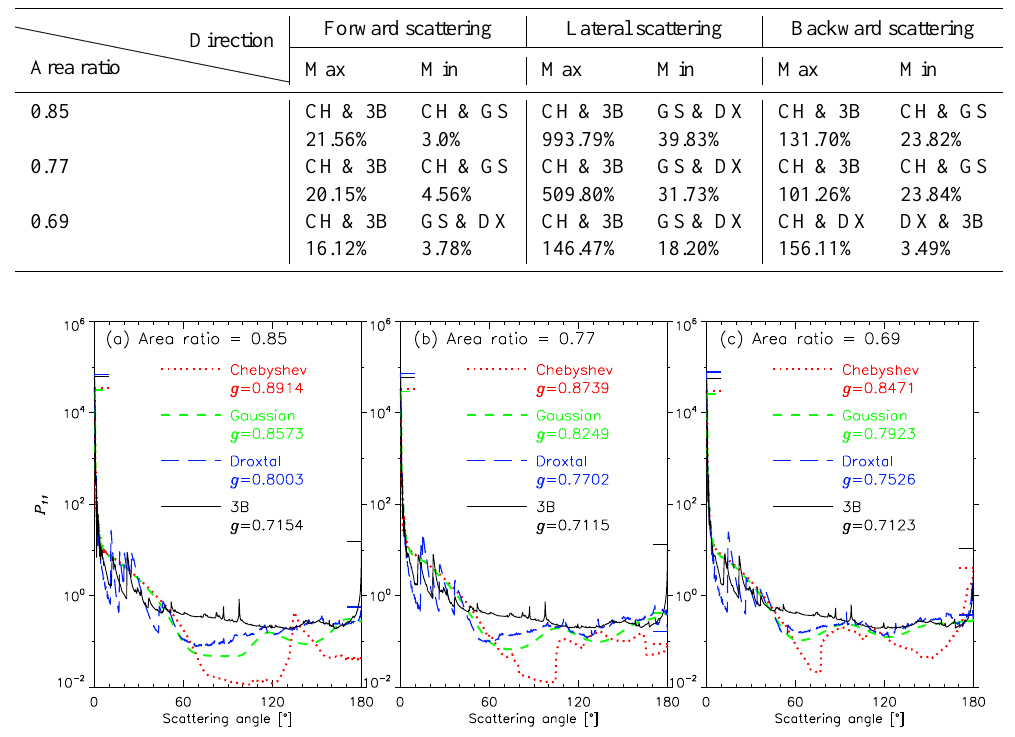
Fig. 12. P 11 and g for Chebyshev particles, Gaussian random spheres, droxtals, and 3Bs with varying area ratio of 0.85 (a) , 0.77 (b) , and 0.69 (c) . Here, aspect ratio of 1.43 is used for 3Bs. The direct forward and backward peaks are indicated by bars. Table 2. Maximum and minimum difference in g of idealized mod- els representing shapes of small ice crystals as a function of the area ratio. For a given area ratio of small ice crystal the maximum and minimum difference (%) between g and the corresponding names of the idealized models are listed. Acronyms for idealized models are the same as in Table